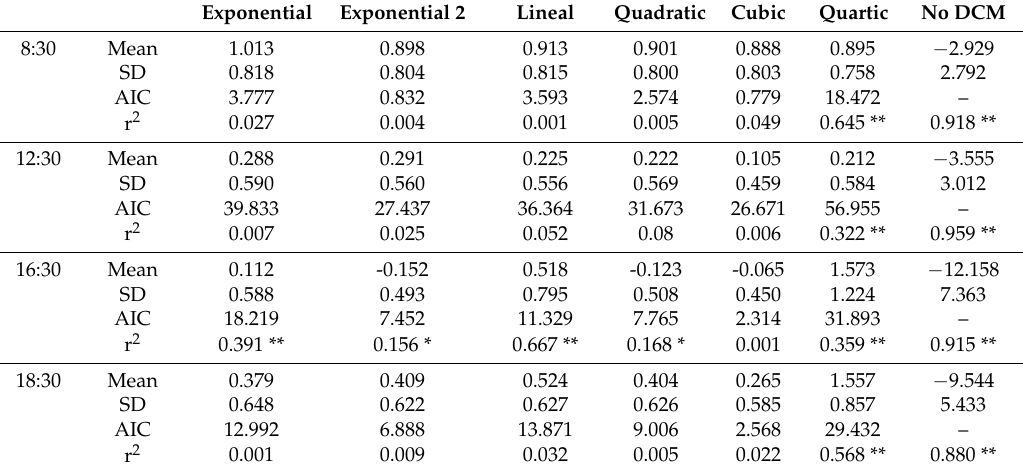
Figure 6. Comparison of thermal orthomosaics at 16:30 p.m. with drift model corrections: ( a ) exponential, ( b ) exponential order 2, ( c ) lineal, ( d ) quadratic, ( e ) bicubic, ( f ) quartic, and ( g ) no correction. Table 4. Mean error, standard deviation (SD), Akaike’s information criterion (AIC), and coefficients of correlation (r 2 ) for each model correction and